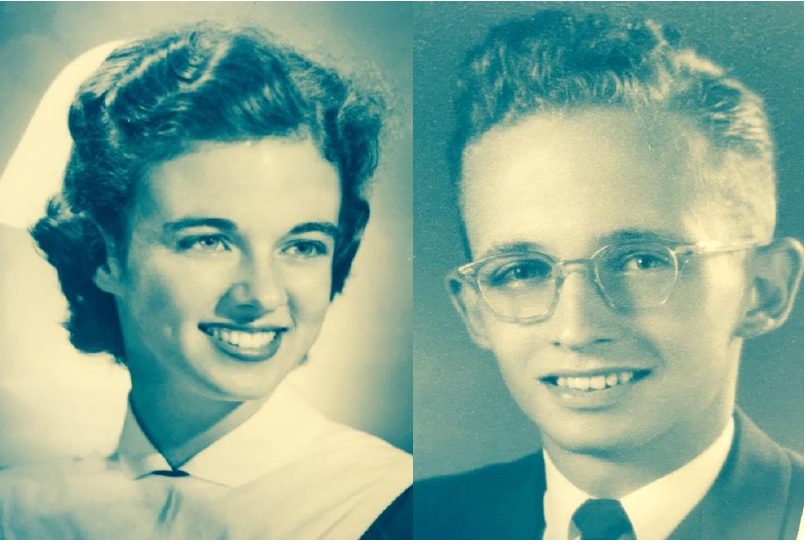
Figure 6. Lois and Morrell Robinson. 79